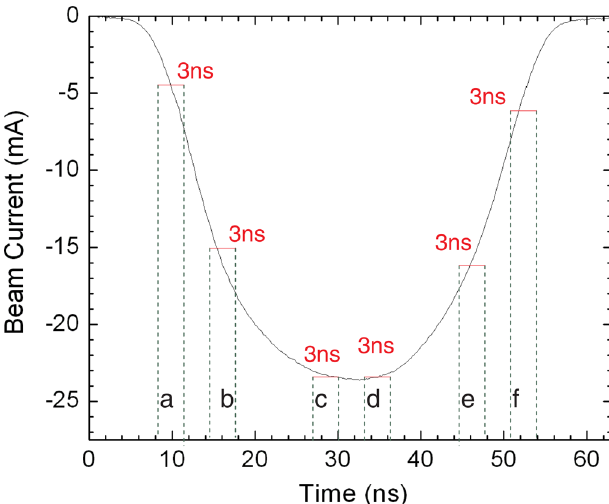
FIG. 6. (Color) Signal collected at the Bergoz coil showing the longitudinal current profile of the parabolic beam, and indicating the approximate locations of the camera gates.